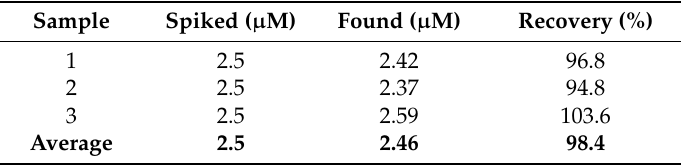
Table 2. Determination of H 2 O 2 in human urine samples at the AgNPs / PEI-decorated electrode ( n = 3).